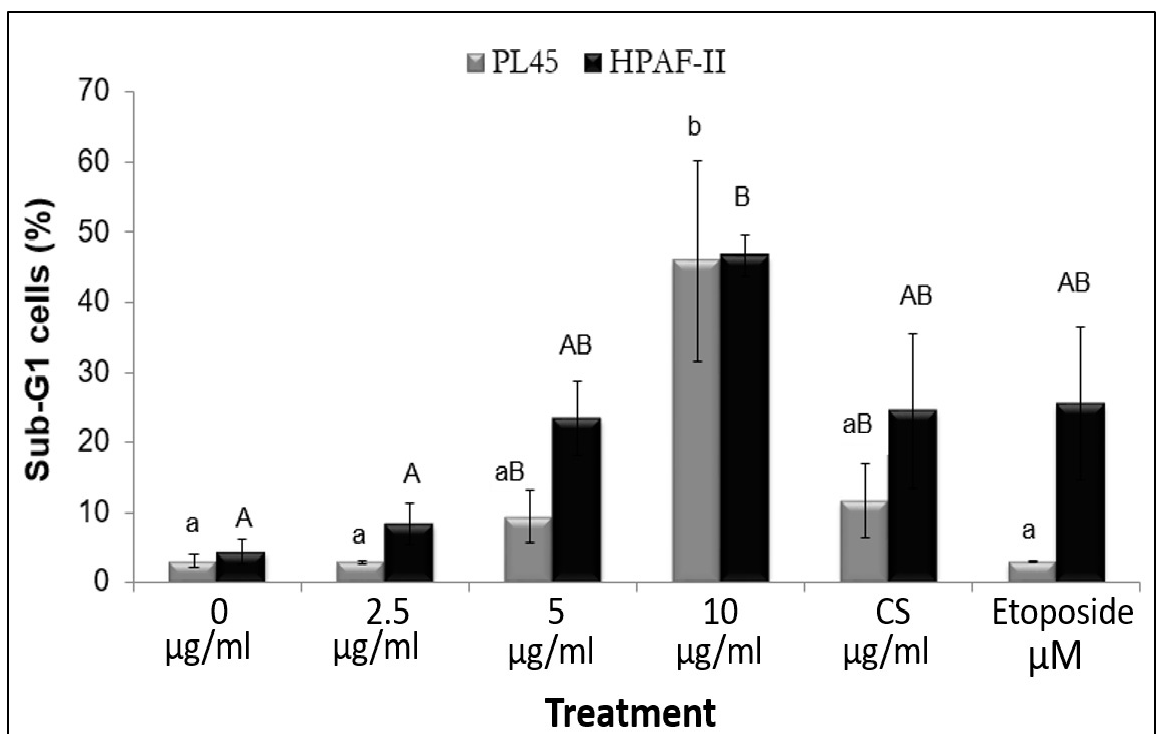
Figure 5. Analysis of cell cycle distribution. HPAF-II and PL45 cells were exposed to medium (control), RT16 (2.5, 5, 10 µ g/mL), CS extract (10 µ g/mL), or etoposide (200 µ M) for 4 h. Cells were then harvested, fixed, and stained with PI and subjected to cell cycle analysis using FACS Calibur. The distribution and percentage of cells in the sub-G1 phase of the cell cycle are presented. Results presented are an average of at least three independent experiments, 3–5 repeats each (means ± SEM). Statistical significance was determined by one-way ANOVA followed by post hoc analysis, p < 0.001. Each letter represents relations to a fellow cell line in the same treatment period.